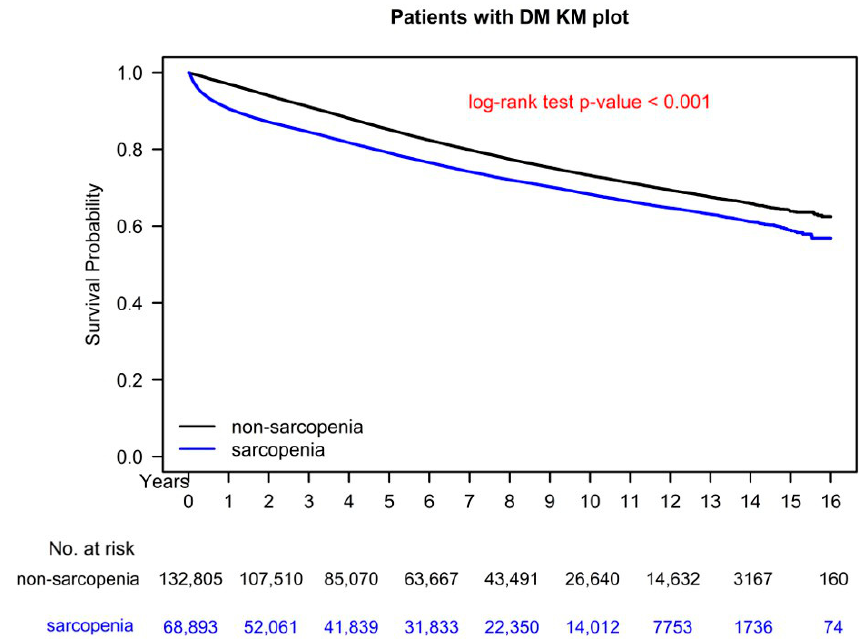
Figure 2. Kaplan–Meier overall survival curves for patients with diabetes with and without sarco- penia.